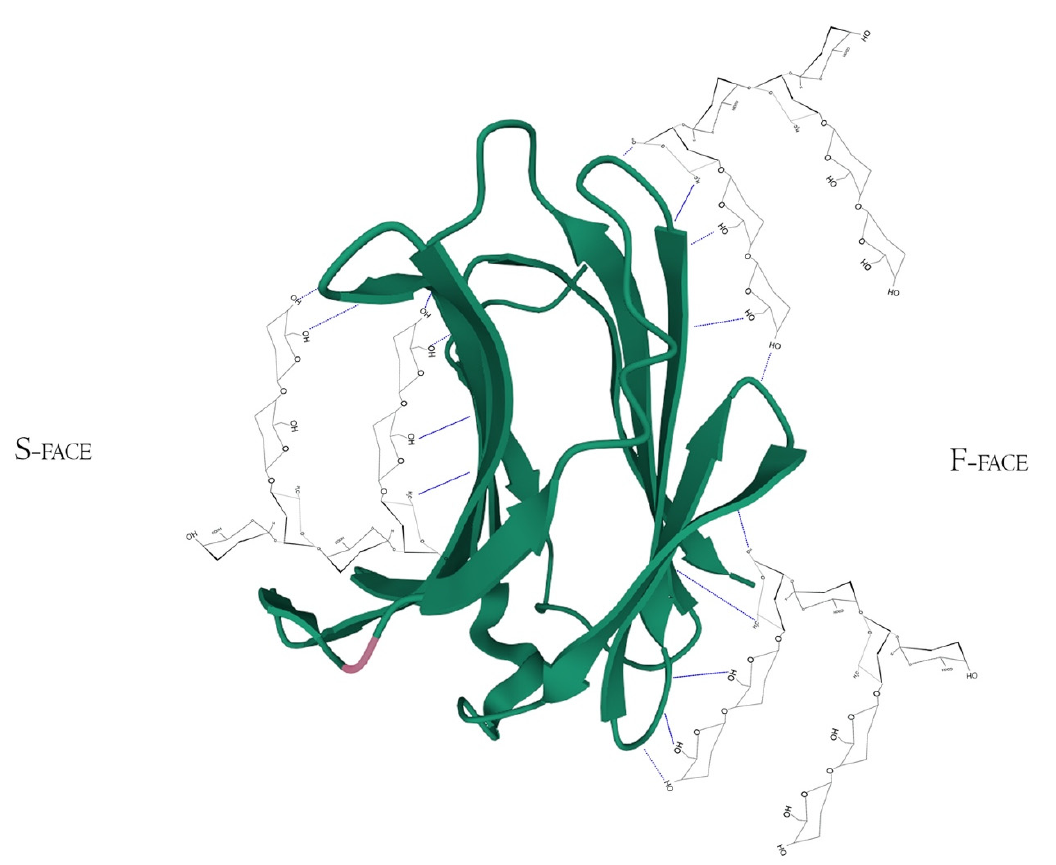
Figure 5. Hypothetical interaction of RG-I fragments with both F and S-face of Galectin-3 simultaneously. Here, the main protagonists would be the β - D -galactopyranose and α - D -galactopyranuronic acid residues and would not act like specific pharmacological inhibitors, but maybe as potential Gal-3-ligand blockers through multivalency or allosteric occupation. Hydrogen bonds are represented by the blue dotted lines. PDB ID 49RB [75,80,81].